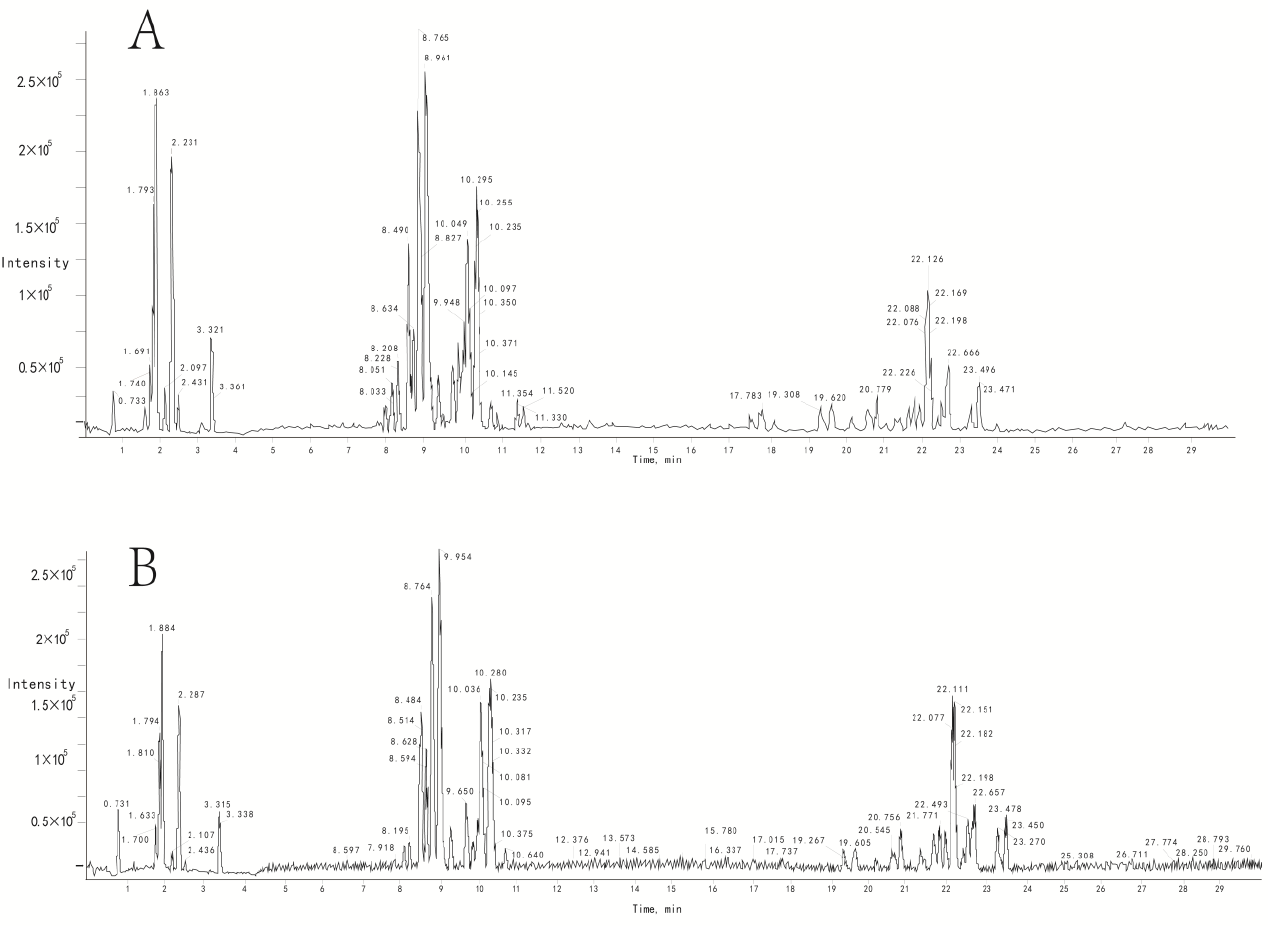
Figure 1. Typical base peak intensity (BPI) chromatogram of rat serum obtained in ESI positive and negative mode based on UPLC/TOF–MS analysis. ( A , B ) Representative BPI chromatogram of rat serum in ESI positive and negative modes, respectively. The UPLC/TOF–MS analysis was performed using an Acquity TMUPLC system (Waters Corporation) coupled to a SynaptTMG2 High-Definition Time-of-Flight Mass Spectrometry system (Waters Corporation) with electrospray ionisation (ESI) in positive and negative modes. In both the positive and negative ion modes, the BPC profiles displayed no difference between the S and C groups. Table 2. Potential biomarkers and related pathways or